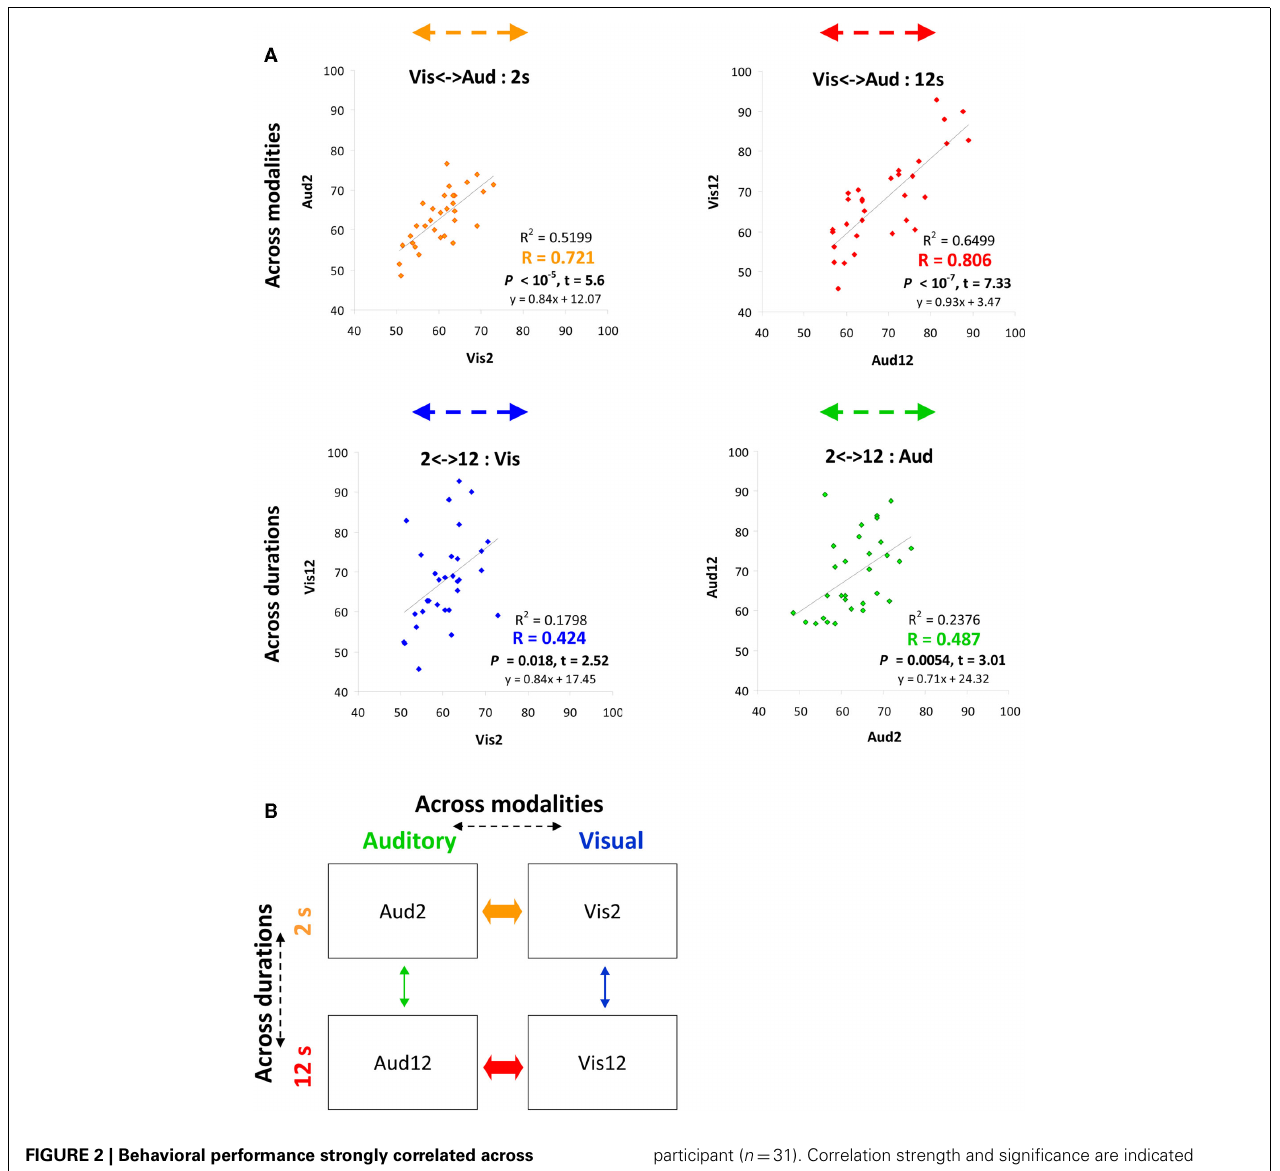
FIGURE 2 | Behavioral performance strongly correlated across different modalities of temporal judgments. (A) Plots convey temporal estimation correlations between conditions either across modalities (top) or across durations (bottom). Colored arrows at the top of each plot correspond to the correlation arrows in Figure 1A . x and y axes indicate accuracy level (% correct) of specific conditions (condition name indicated on axis title). Each point depicts data from one